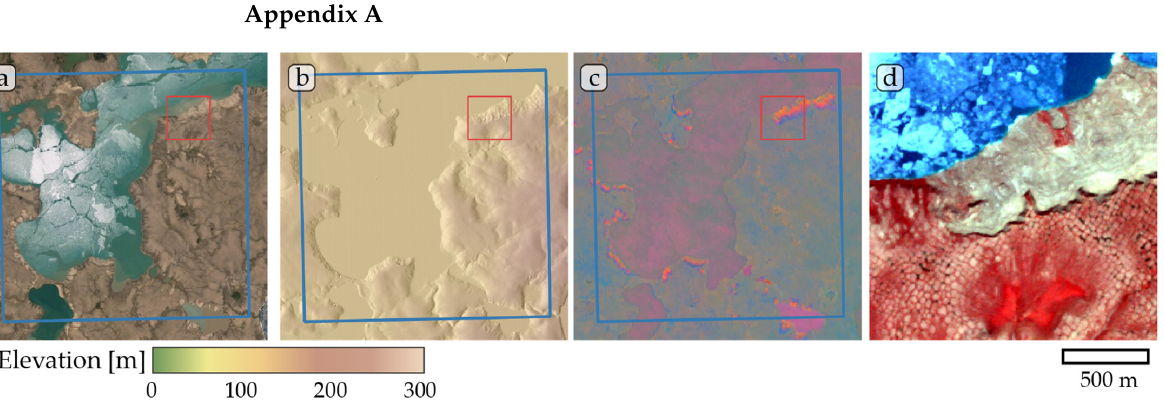
Figure A1. Study site Banks Island 01. ( a ) ESRI satellite layer, ( b ) ArcticDEM superimposed with hillshade, ( c ) Tasseled Cap trend visualization, ( d ) PlanetScope satellite image (NIR-R-G) acquired on 26 July 2019. Blue box, 10 × 10 km study site. Red box detailed view of ( d ).